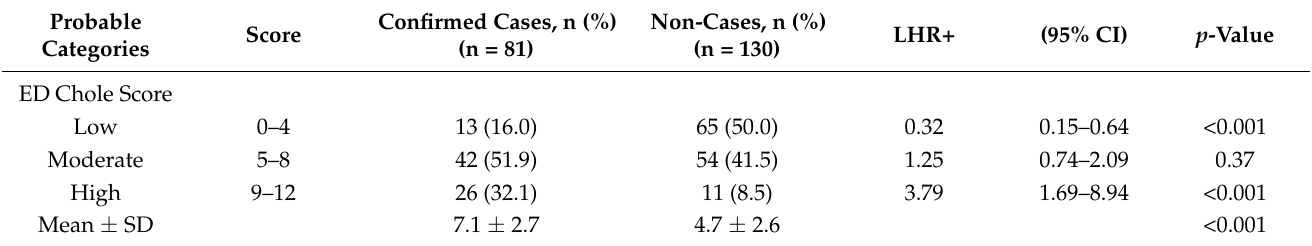
Figure 2. Receiver operating characteristic curve in the diagnostic prediction of acute cholecystitis of ED Chole Score within the development cohort.